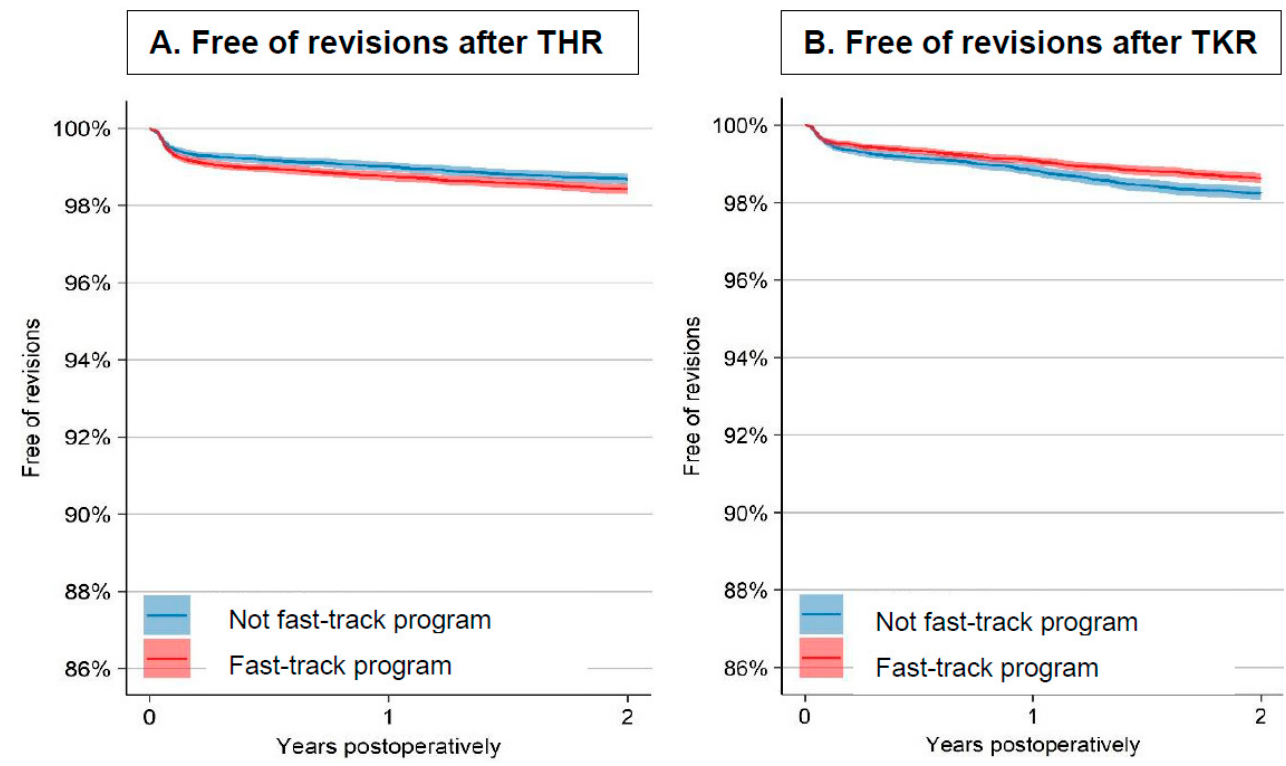
Figure 2. Kaplan–Meier curves for implant survival (free of revisions) within 2 years after THR and TKR. Y-axis truncated in the diagram. A . Free of revisions after THR; B . Free of revisions after TKR.